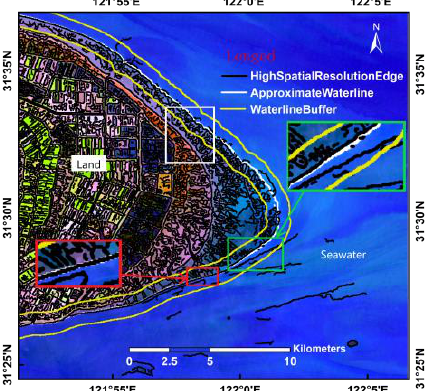
Figure 3. On the remote sensing image of 20 April 2007, the features of the edge spatial relationship with high resolution.